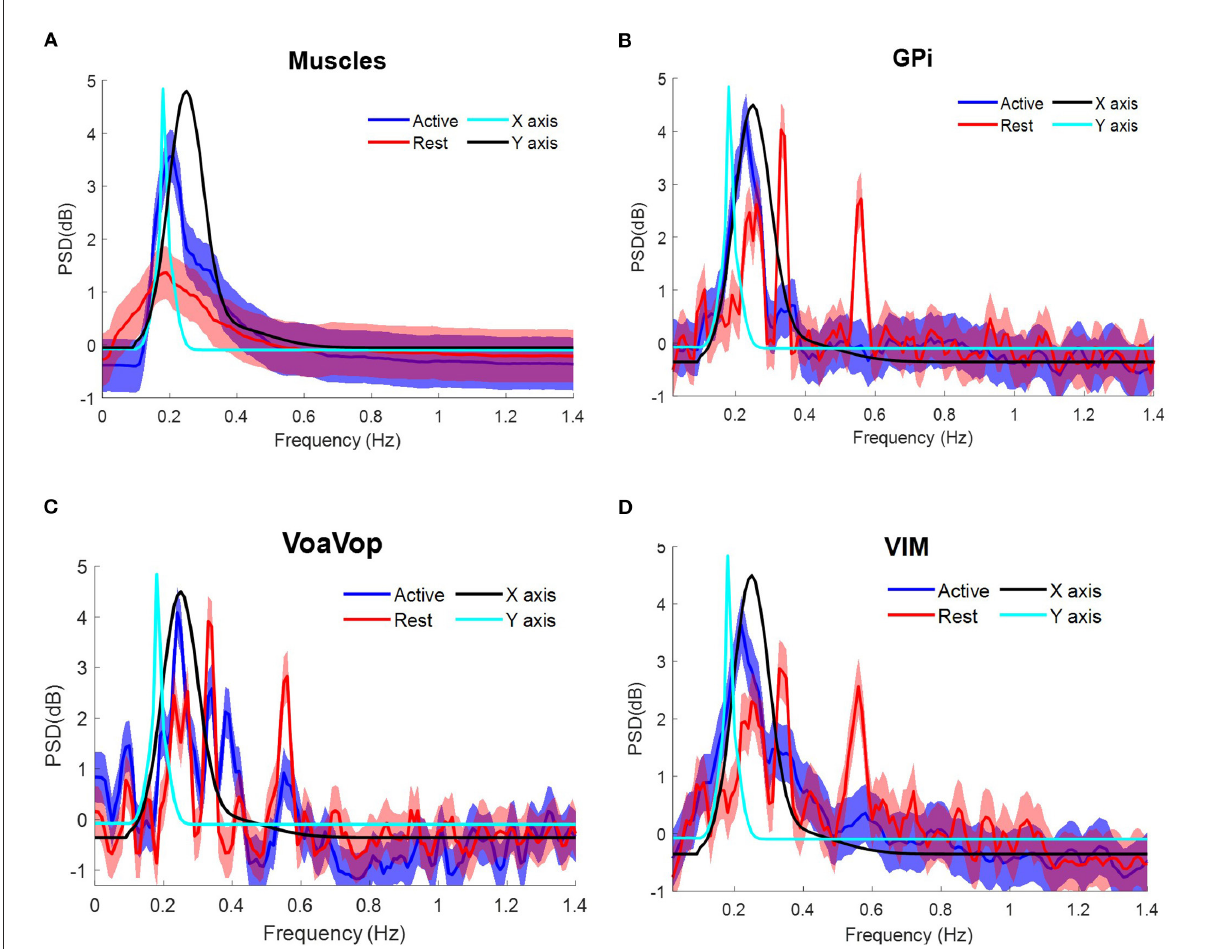
FIGURE4 Task frequency components for the patient with generalized dystonia. Contralateral muscles and brain signals during the figure-eight drawing task, recorded from multiple surface EMGs and from multiple externalized DBS electrodes. Power spectrum density (PSD) for kinematic data is shown for comparison: f y component (cyan) and f x component (black). Grand average and standard deviation across all muscles and all microwire electrode recordings during all repetitions of the figure-eight drawing (blue) and resting (red) conditions. (A) Grand average across contralateral muscles. Grand average of left-side brain targets. (B) Brain signals from globus pallidus interna (GPi). (C) ventral oralis anterior/posterior (VoaVop), (D) ventral intermediate (Vim). Vertical axis: power spectra (dB). Horizontal axis: frequency